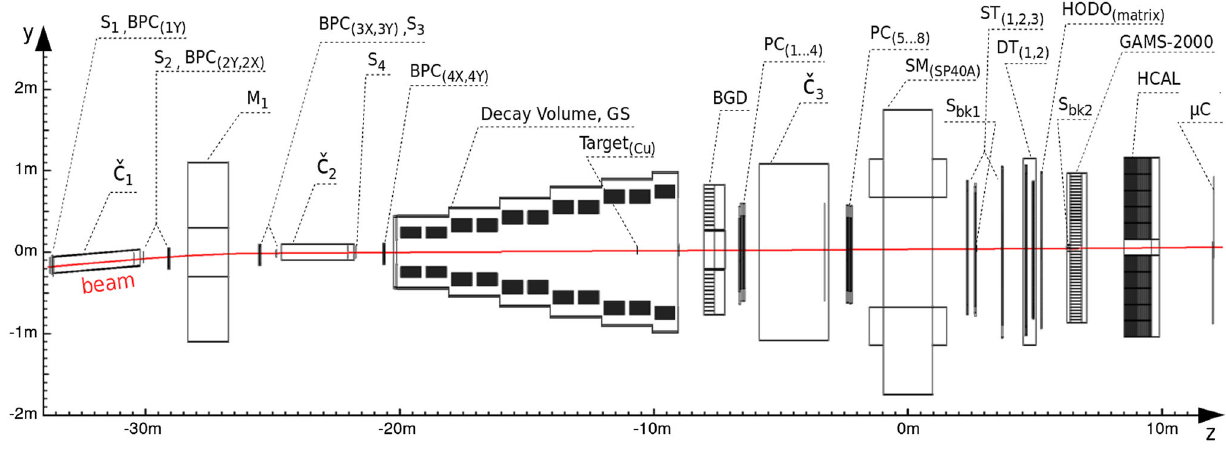
Fig. 2 Layout of the OKA detector, reproduced from